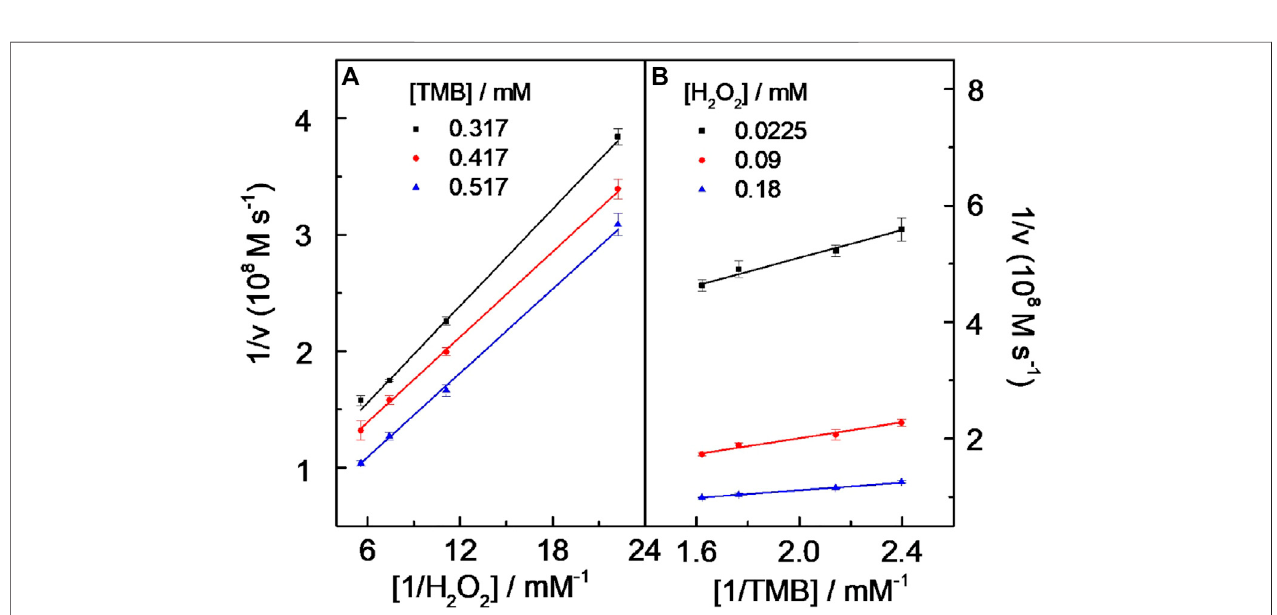
FIGURE 6 | Double reciprocal curves of peroxidase-like catalytic activity of the CDs toward the TMB – H 2 O 2 system at a fi xed concentration of one substrate vs. varying concentrations of the second substrate for TMB (A) and H 2 O 2 (B) . Experiment conditions are as follows: 0.2 M NaOAc – HOAc buffer solution with a pH value of 4.2 containing 40 μ g ml − 1 CD solution and a temperature of 35 ° C. The error bars represent the standard deviation of three parallel measurements.